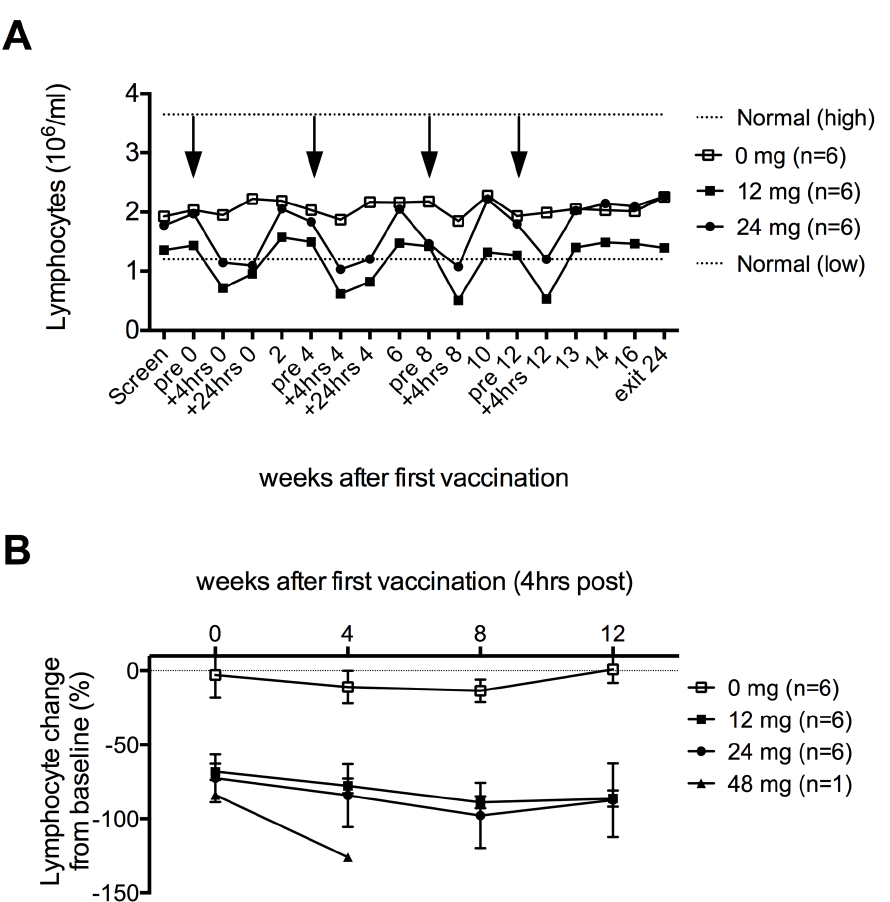
Figure 6. Transient and treatment specific lymphopenia after vaccination. Total lymphocyte counts were performed before, during and at follow up after vaccination as indicated on the x-axis for the three groups (0 mg, 12 mg and 24 mg) and shown as mean values (million lymphocytes per ml whole blood) for the 6 subjects within each group with normal high and low values for HIV positive individuals indicated by dotted lines (A). Arrows indicate vaccinations. The percent (%) change of lymphocyte count from baseline (week 0) is shown as mean values for the three dose groups with error bars representing standard error of mean (SEM) (B). Only one subject (024) was available for the 48 mg dose group at week 0 and 4.